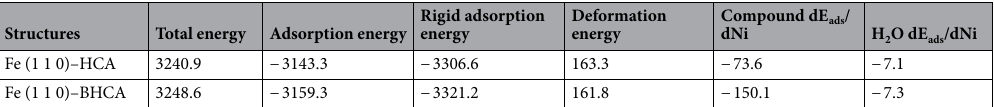
Table 9. “Equilibrium adsorption configurations of the inhibitor molecules on the Fe (110) surface: side view and top view”.